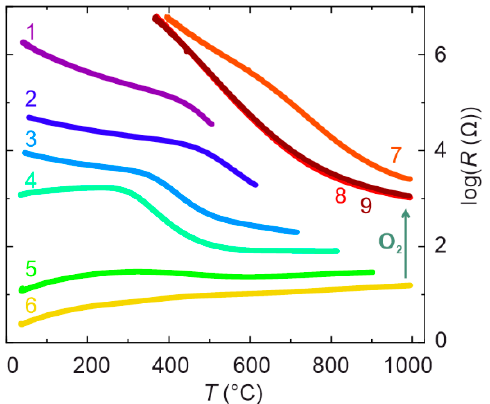
Figure 4. Overview of the measured bulk resistances obtained during cooling under vacuum conditions. The numbers indicate the sequence of the measurements.